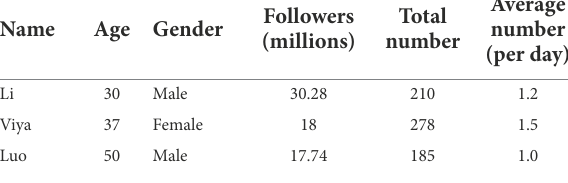
TABLE 1 Overview of the three key opinion leaders (KOLs’) Weibo